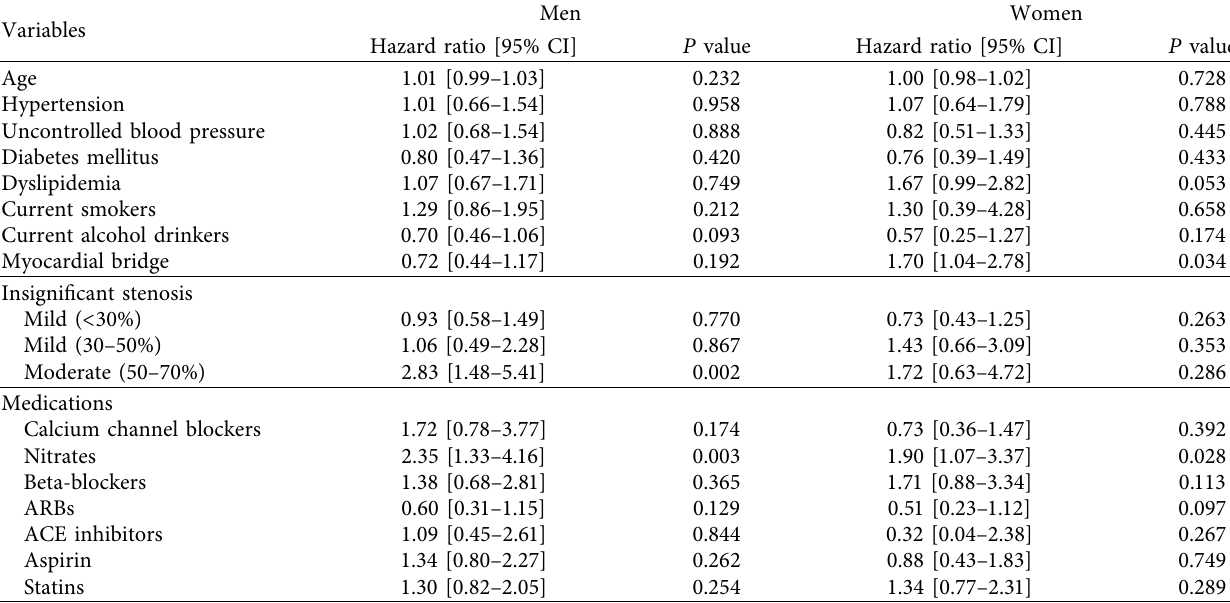
Table 6: Independent risk factors of recurrent angina in CAS patients at follow-up period using multivariable Cox-proportional hazard ratio model